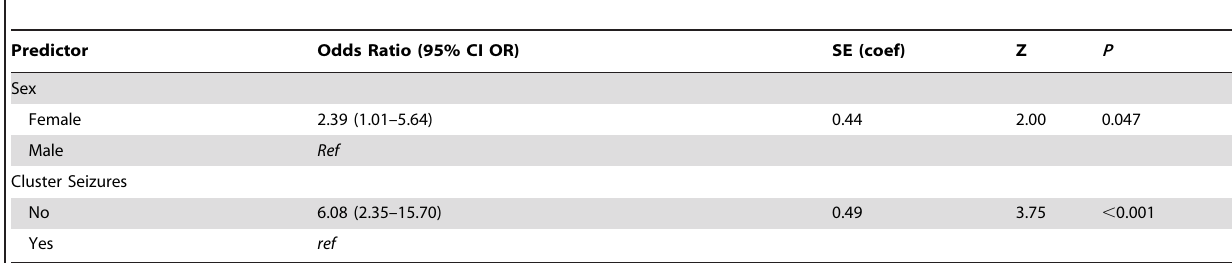
Table 3. Risk factors for remission in canine epilepsy cases.